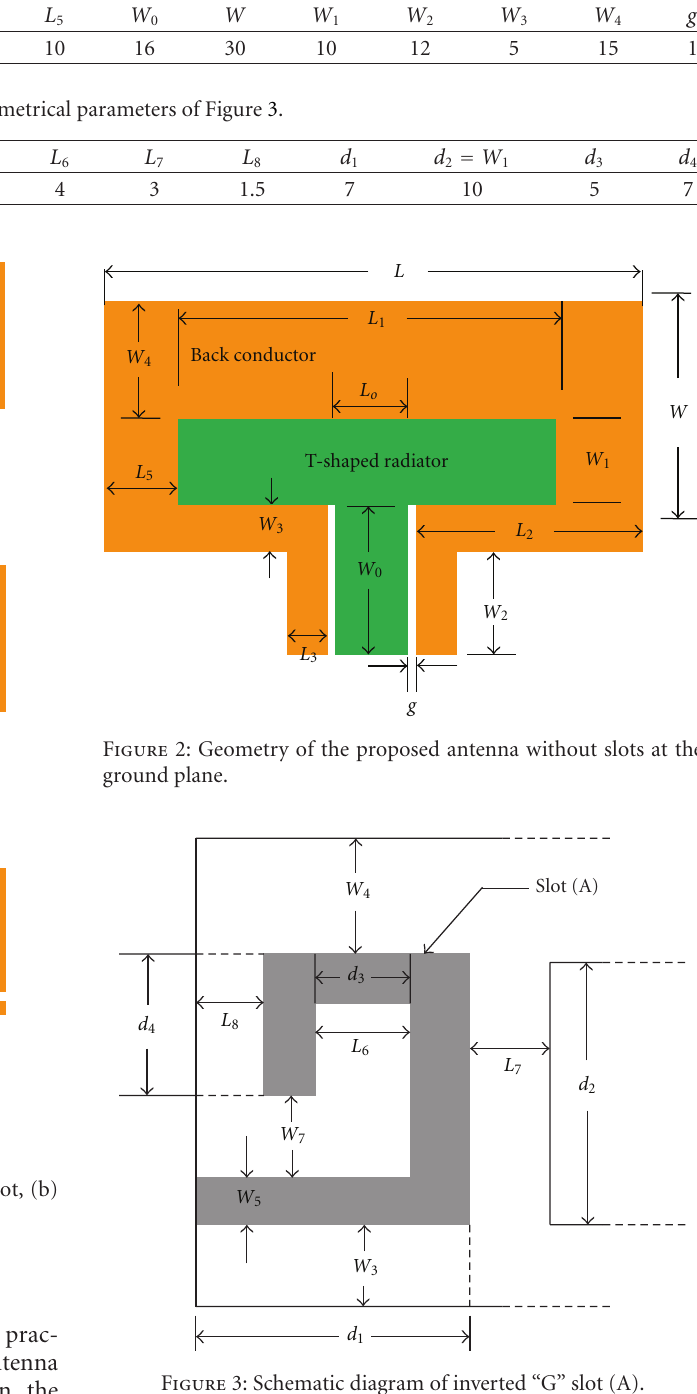
Figure 3: Schematic diagram of inverted “G” slot